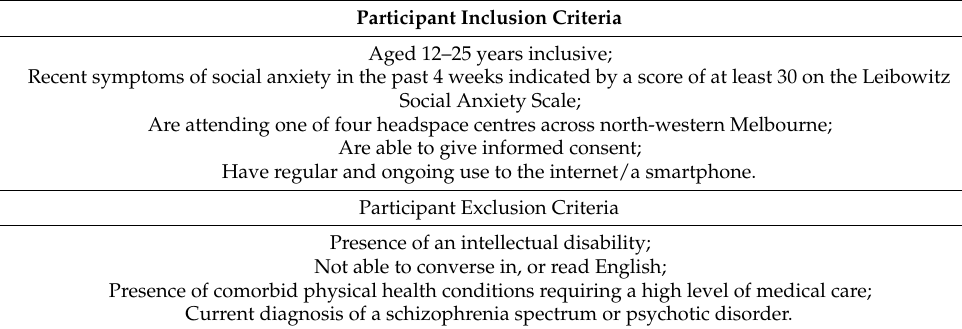
Table A1. Entourage Study Inclusion and Exclusion